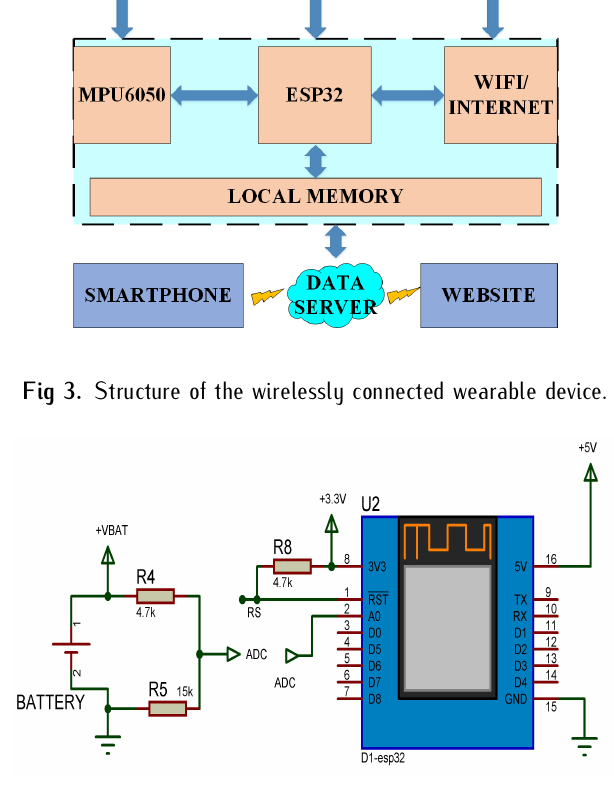
Fig 4. A voltage divider circuit diagram for battery power